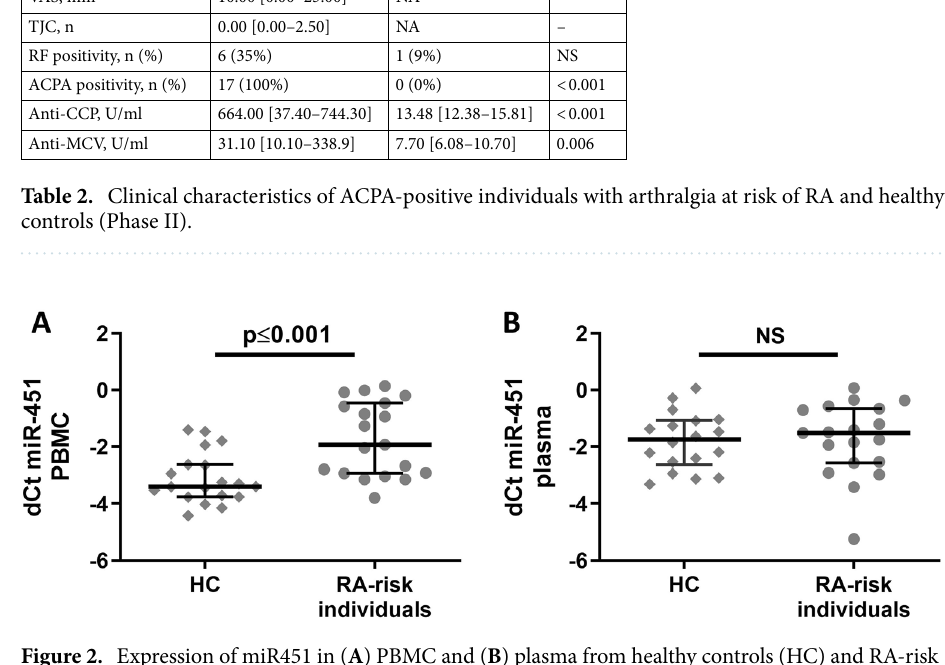
Figure 2. Expression of miR451 in ( A ) PBMC and ( B ) plasma from healthy controls (HC) and RA-risk individuals with arthralgia in the validation cohort using single assays. NS, not significant